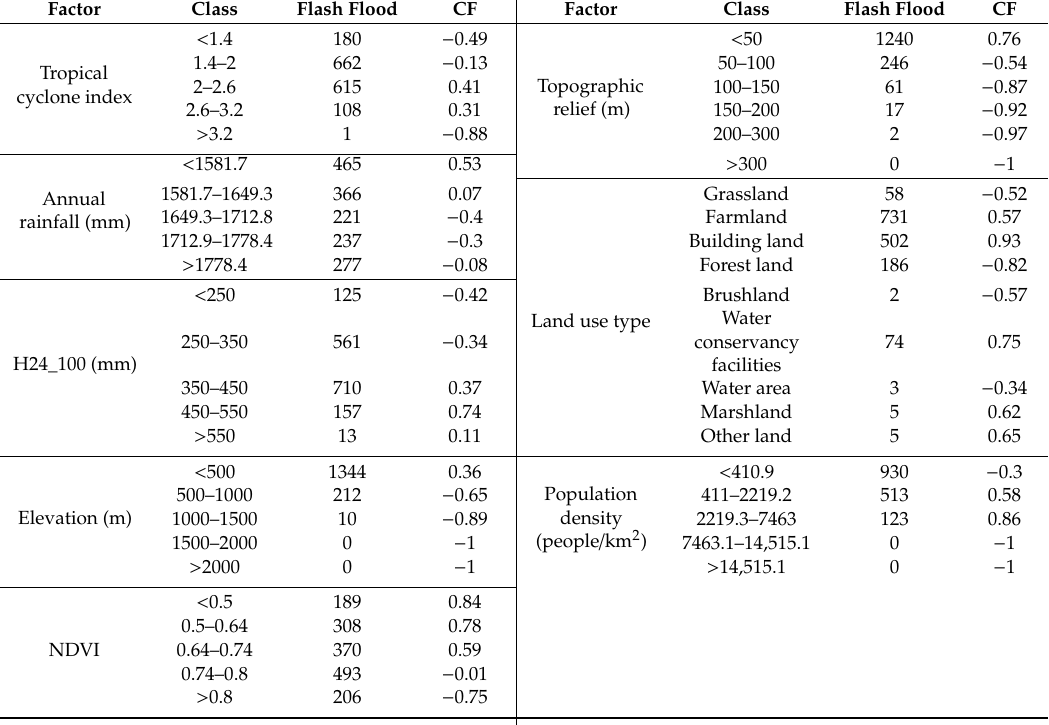
Table 4. CF values of the assessment